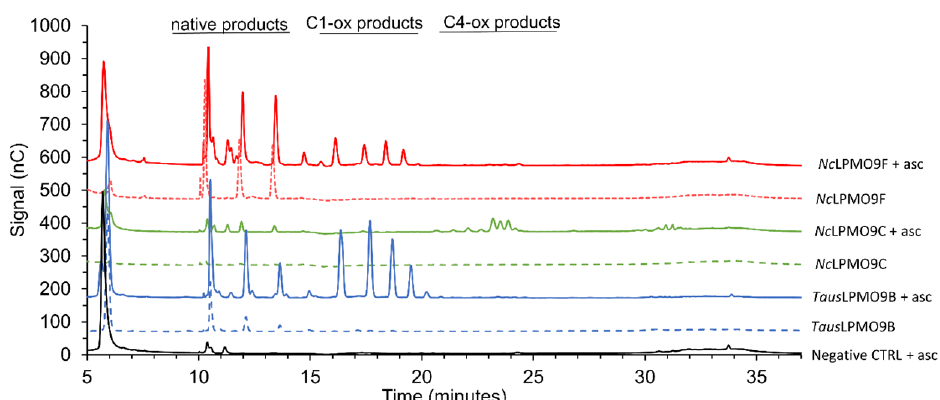
Figure 4. Products released from cellulose by different AA9s [47]. Strictly C1-oxidizing LPMOs ( Taus LPMO9B, blue line; Nc LPMO9F, red line) and strictly C4-oxidizing LPMO ( Nc LPMO9C, green line) in the presence (solid lines) or absence (dotted lines) of ascorbic acid (asc). The black solid line represents the negative control containing all components of the reaction mixture except for the enzyme.